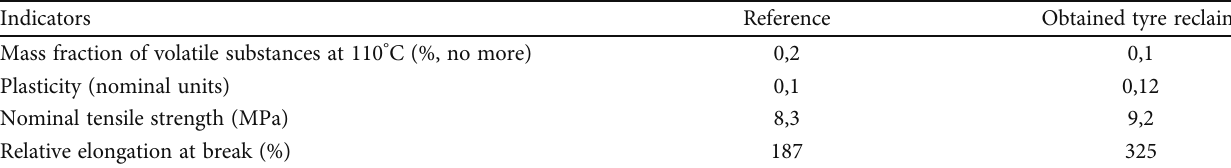
Table 5: The tyre reclaim